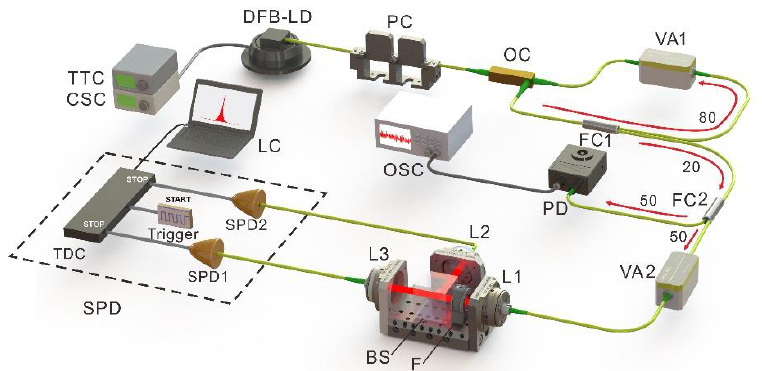
Figure 1. Schematic diagram of the experimental setup for measuring photon correlation g (2) ( τ ) of a chaotic optical-feedback laser. DFB-LD: distributed feedback 1550 nm laser diode; PC: polarization controller; OC: optical circulator; VA1 and VA2: variable optical fiber attenuator; FC1 and FC2: fiber coupler; PD: high-speed photodetector; L1, L2 and L3: aspheric lens collimator; BS: beam splitter; F: optical filter; SPD: single photon detector; TDC: time to digital converter; LC: laptop computer; OSC: oscilloscope; TTC: thermoelectric temperature controller; CSC: current source controller.